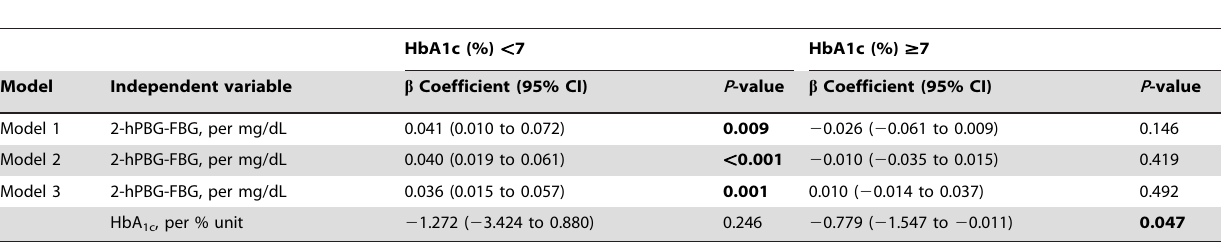
Table 2. Multiple linear regression analysis of association of 2-hPBG-FBG with eGFR.